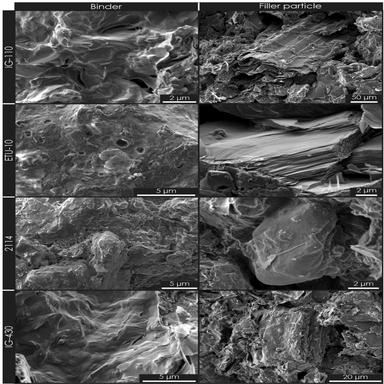
Fractography SEM micrographs of the binder and filler of fine graphite grades.